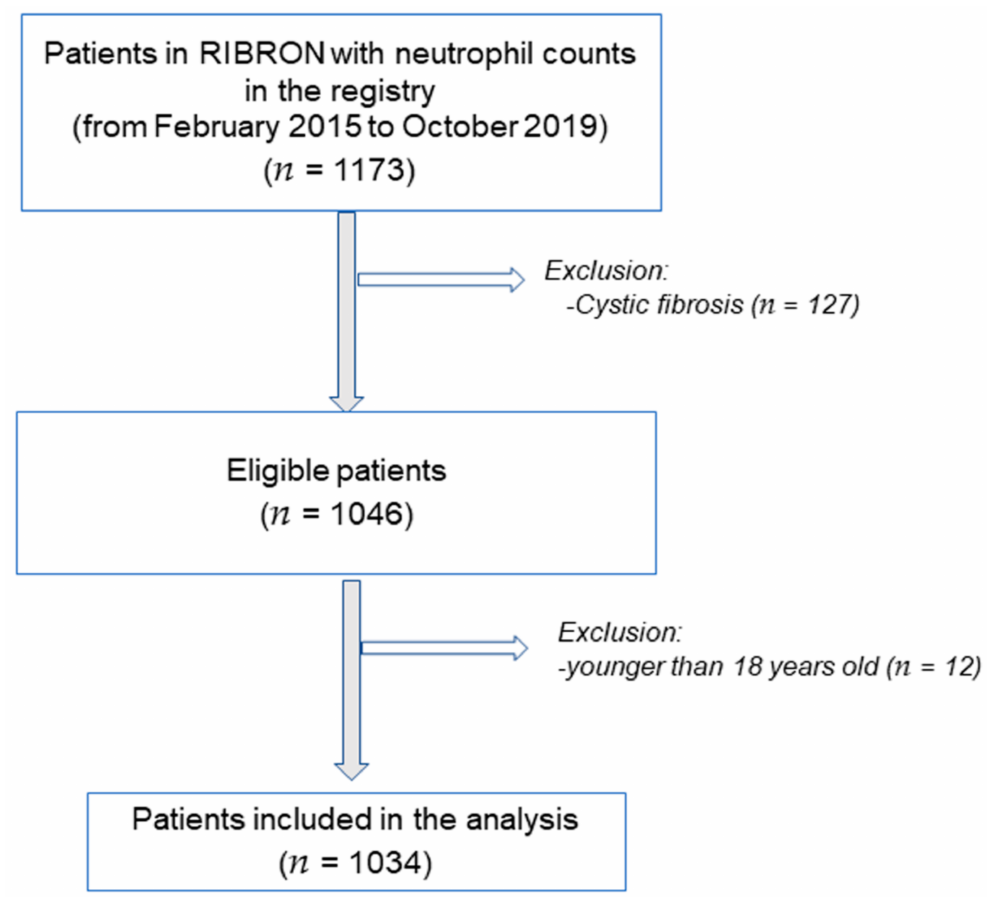
Figure 1. Schematic representation of the flow of the